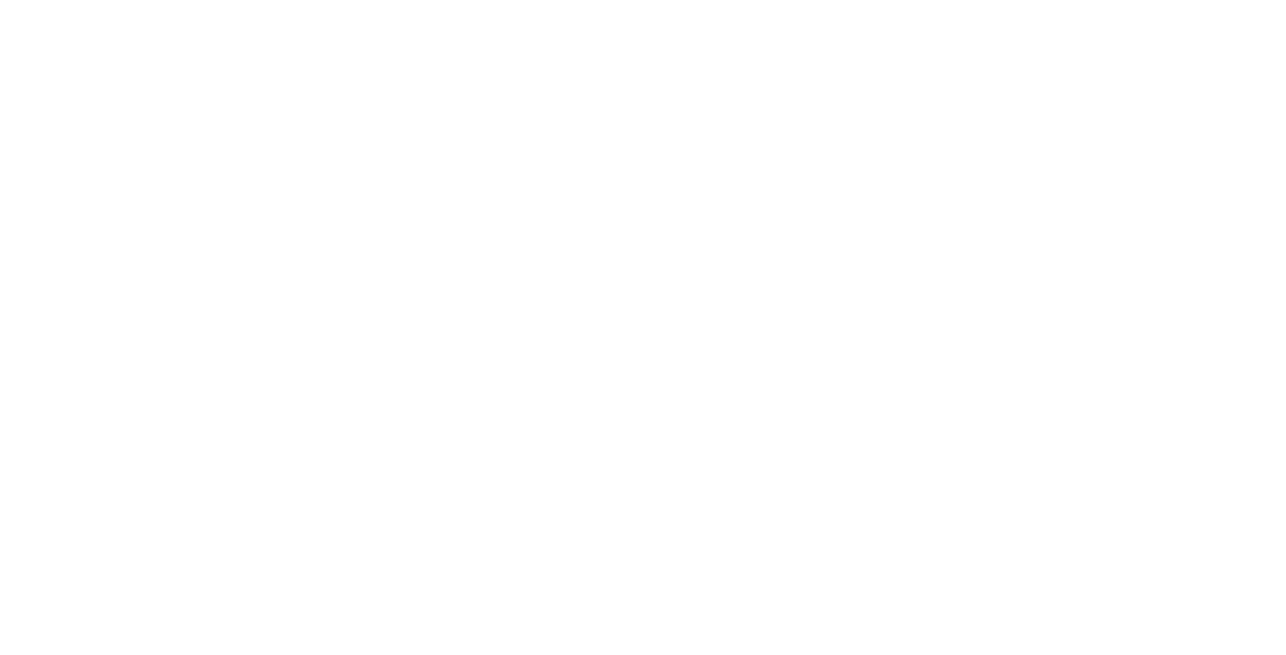
Frontiers in Earth Science |